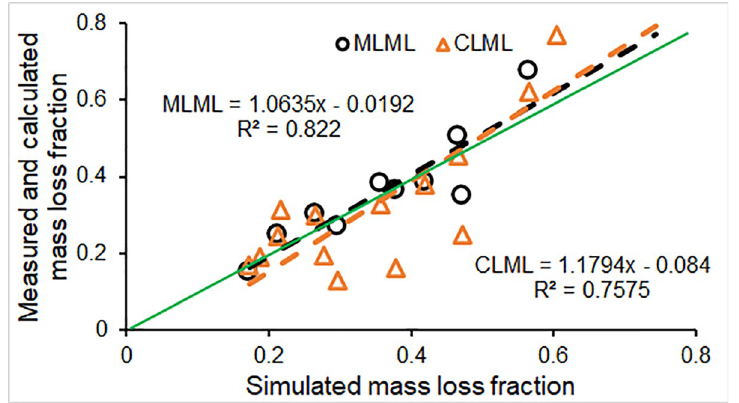
Fig 4. Results from model validation: Comparing simulated log mass loss fraction to measured loss fraction in situ (MLML), and the calculated loss fraction based on the disk wood density loss (CLML); black dashed line, regressed relationship between the measured mass loss and the simulated loss; orange dashed line, regressed relationship between the calculated mass loss and the simulated loss; green line, 1:1.